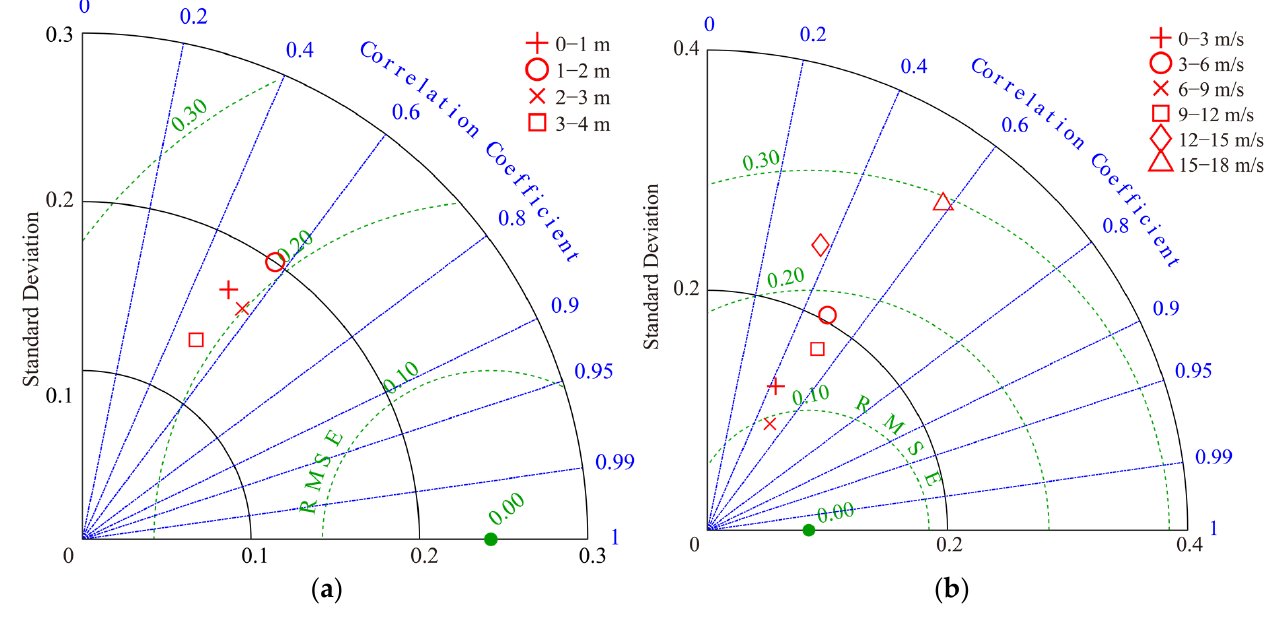
Figure 5. ( a ) Validation of WW3-simulated SWHs against ERA-5 for SWHs of 0–4 m; and (b) vali- dation of WW3-simulated whitecap coverage against NDBC buoy data at wind speeds 0–18 m/s.